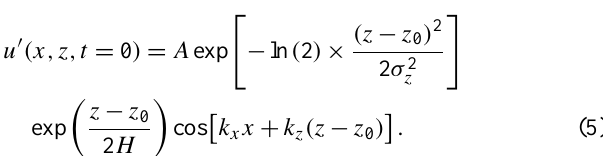
Figure 1. Temperature profiles (the black lines, the bottom x axis) calculated from NRLMSIS-00 at three latitudes (0 ◦ : the solid line, 70 ◦ N: the dash line, 70 ◦ S: the dash dot line) on day 355 and the corresponding buoyancy frequency (the red lines, the upper x